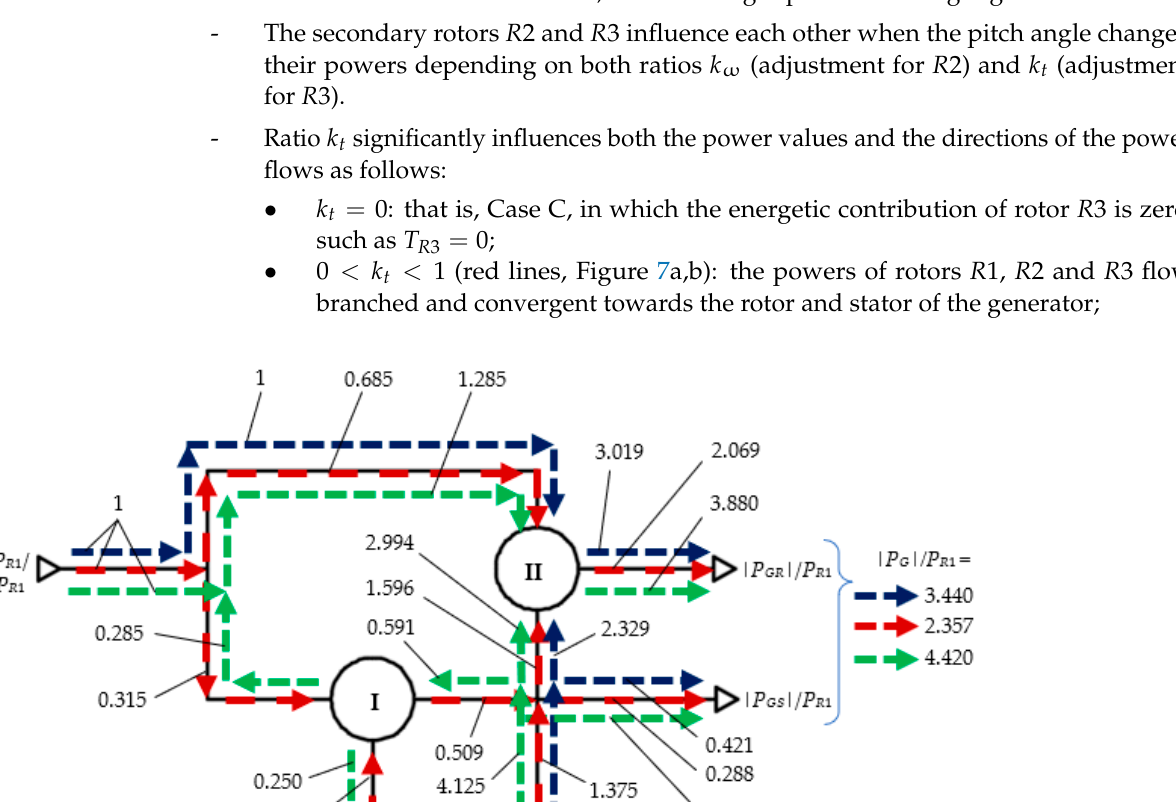
Table 5. Based on the obtained data, the following aspects can be highlighted: